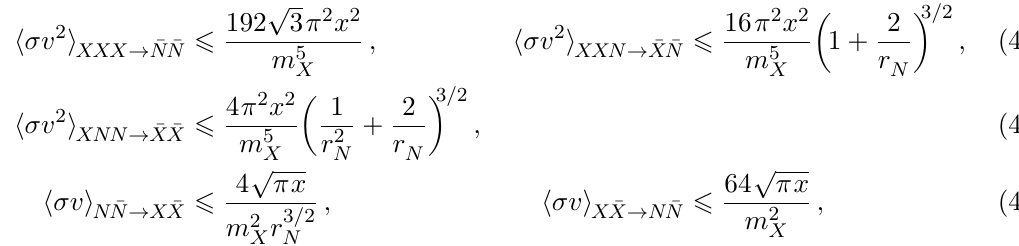
and I as functions of r 1 2 ∼ O (0 . 1) in the mass range of 1 , 2